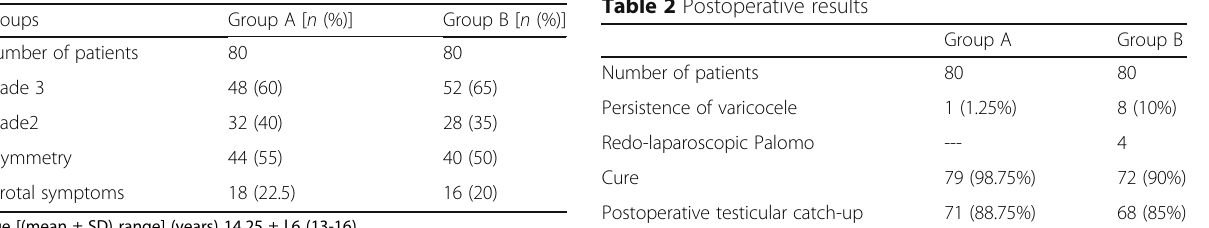
Table 1 Demographic data and clinical presentation in both